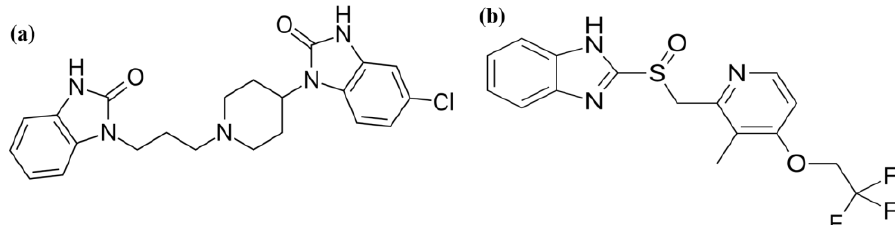
Figure 1. Chemical structures of ( a ) domperidone and ( b ) lansoprazole.